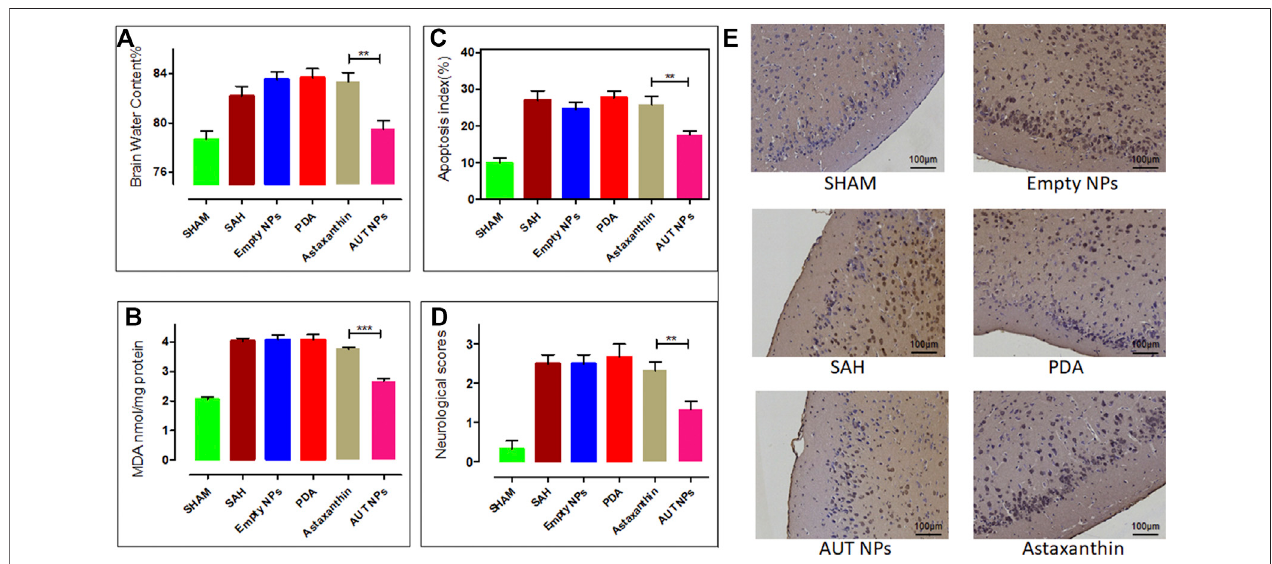
FIGURE 9 | The in vivo therapeutic effect of AUT NPs, including the brain water content (A) , the brain MDA level (B) , the statistics of apoptosis rate (C) , the neurological score (D) , and the TUNEL stained slice images of brain tissues in different groups (E) . The ** p < 0.01, ( n (cid:2) 6); and *** p < 0.001, ( n (cid:2) 6).